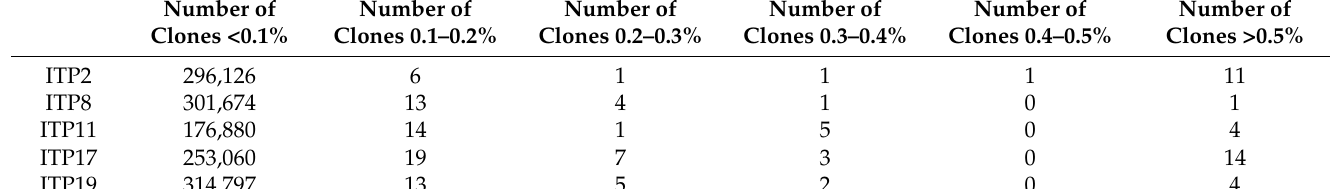
Table 5. The distribution of CD4 + T cell repertoire in peripheral blood after treatment.